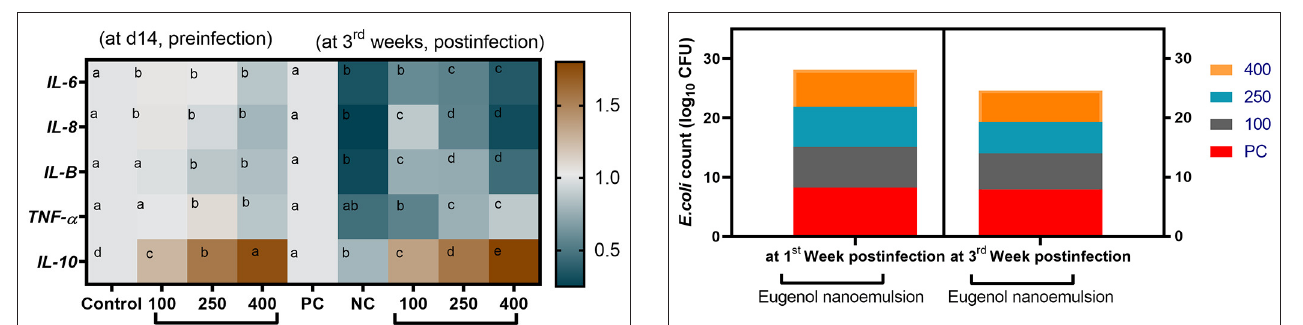
FIGURE 6 | Quantification of cecal APEC O78 loads (log 10 CFU) in response to eugenol nanoemulsion supplementation at the 1st and 3rd weeks post-challenge as was measured by qPCR assay. Values are means with their SE. NC (negative control): birds fed basal diet without eugenol nanoemulsion and were not challenged, PC (positive control): birds fed a control diet without eugenol nanoemulsion and were challenged, eugenol nanoemulsion 100, 250, and 400: birds fed basal diet supplemented with 100, 250, and 400 mg/kg diet eugenol nanoemulsion. All groups except NC were challenged with E. coli O78 at 14 days of age.